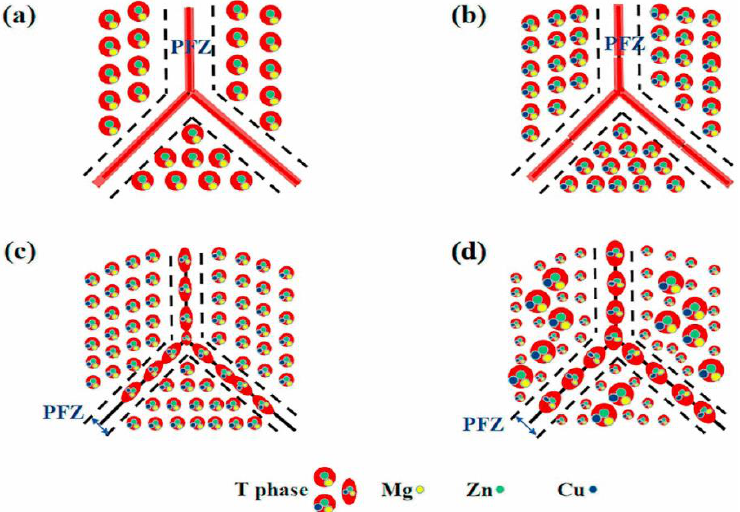
Figure 8. Schematic diagram of the mechanical properties and the IGC resistance of Al-Mg-Zn(-Cu) alloys: ( a ) (Zn + Cu)/Mg = 0.63, ( b ) (Zn + Cu)/Mg = 0.71~0.85, ( c ) (Zn + Cu)/Mg = 0.97, ( d ) (Zn + Cu)/Mg = 1.21 [19].